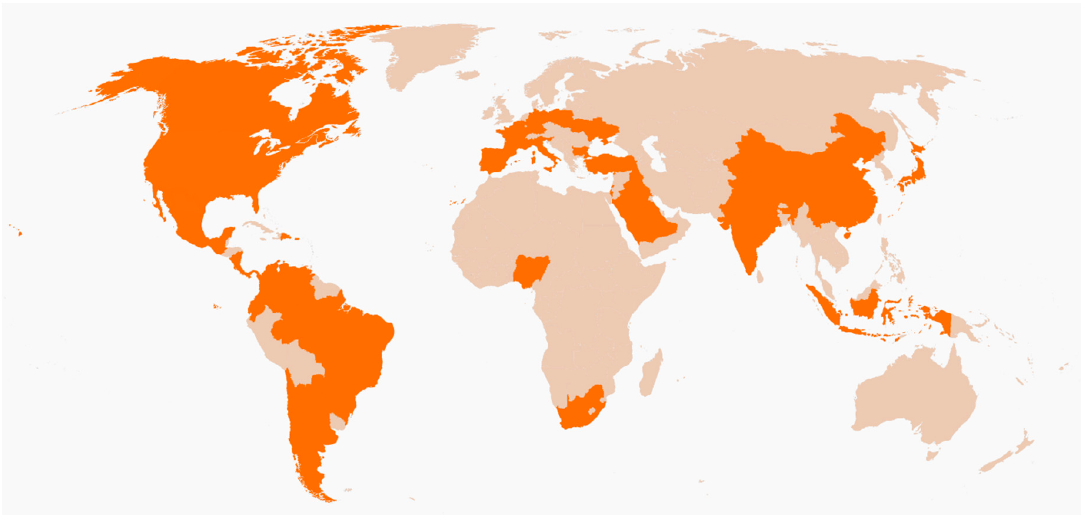
Figure 1. World map depicting countries where the study was conducted in in orange.